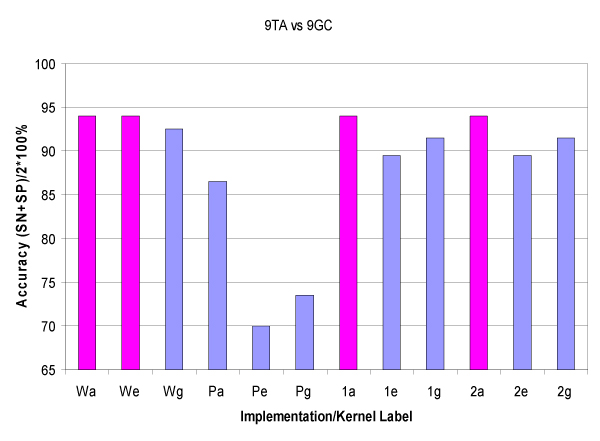
Comparative results are shown on performance of Kernels and algorithmic variants. The classification is between two DNA hairpins (in terms of features from the blockade signals they produce when occluding ion flow through a nanometer-scale channel). Implementations: WH SMO (W); Platt SMO (P); Keerthi1 (1); and Keerthi2 (2). Kernels: Absdiff (a); Entropic (e); and Gaussian (g). The best algorithm/kernel on this and other channel blockade data studied has consistently been the WH SMO variant and the Absdiff and Entropic Kernels. Another benefit of the WH SMO variant is its significant speedup over the other methods (about half the time of Platt SMO and one fourth the time of Keerthi 1 or 2).